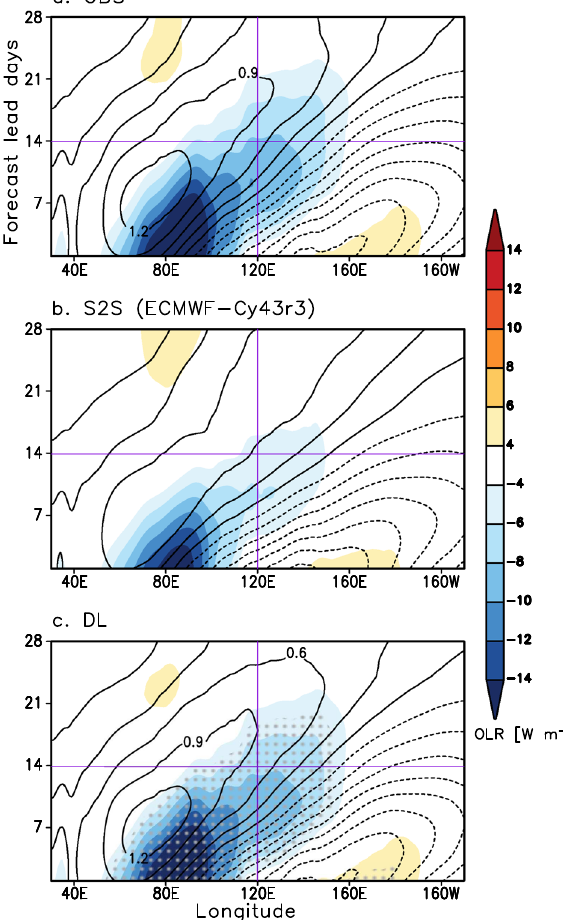
Fig. 4 Observed and forecasted Madden-Julian oscillation (MJO) propagation. Reconstructed 15°S-15°N mean Outgoing Longwave Radiation (OLR) (W m − 2 , shading) and zonal wind at 850 hPa (U850) (contour interval of 0.3 m s − 1 ) anomalies using the composite of the Real-time Multivariate MJO indices (RMMs) starting from phase 2 shown in Supplementary Fig. 2a for ( a ) observations, ( b ) Subseasonal-to-seasonal (S2S) reforecasts, and ( c ) Deep learning (DL)-corrections. Purple lines indicate day 14 and 120 ˚ E. The stipples mark where the OLR anomalies from DL-correction are signi fi cantly different from S2S results at the 95% con fi dence level using the bootstrap